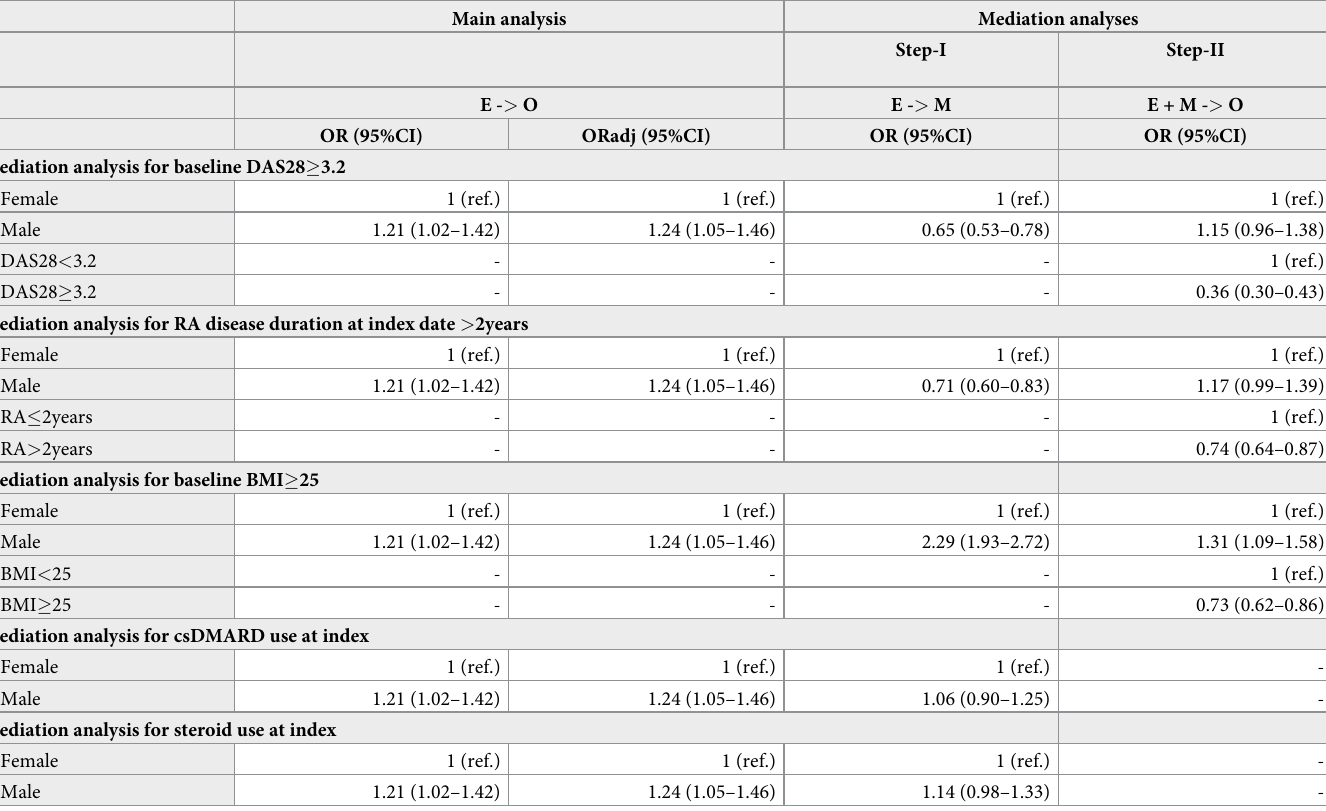
Table 3. Summary findings from the mediation analyses (steps I and II), and findings from the main analysis for